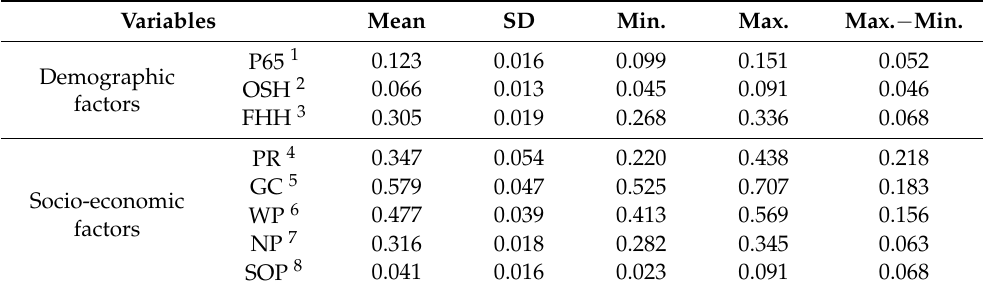
Table 1. Descriptive statistics for demographic and socio-economic factors across 25 districts in Seoul in 2014 for men and